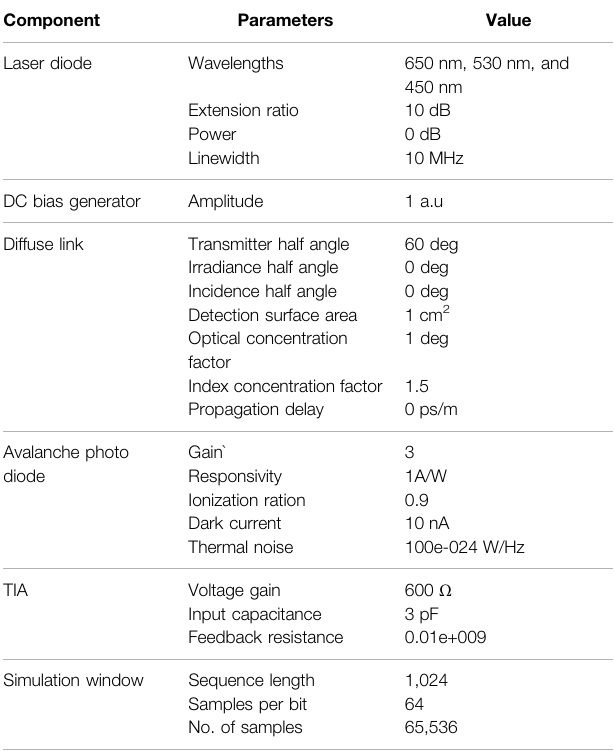
TABLE 1 | Modeling parameters for the proposed WDM-PDM-VLC